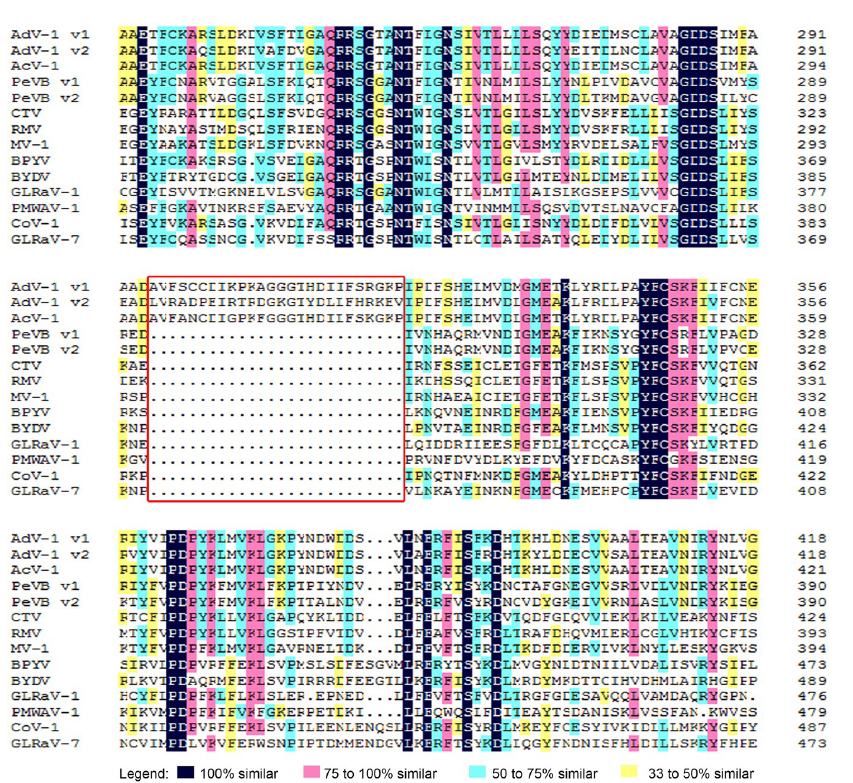
Fig 2. Multiple sequence alignments of RdRp proteins from AdV-1 variants and other species in the family Closteroviridae . Gaps ( � ) had been introduced to optimize alignment. The unique 26-aa inserts are boxed in red. The RdRp proteins of Actinidia virus 1 (KX857665), Persimmon virus B variant 1 (NC025967), Persimmon virus B variant 2 (AB923925), Citrus tristeza virus (KU883267), Raspberry mottle virus (NC008585), Mint virus 1 (NC006944), Beet pseudo-yellows virus (NC005209), Bean yellow disorder virus (NC010560), Grapevine leafroll-associated virus 1 (NC016509), Pineapple mealybug wilt-associated virus 1 (AF414119), Cordyline virus 1 (HM588723), and Grapevine leafroll-associated virus 7 (HE588185) are abbreviated as AcV-1, PeVB v1, PeVB v2, CTV, RMV, MV-1, BPYV, BYDV, GLRaV-1, PMWaV-1, CoV-1 and GLRaV-7, respectively.